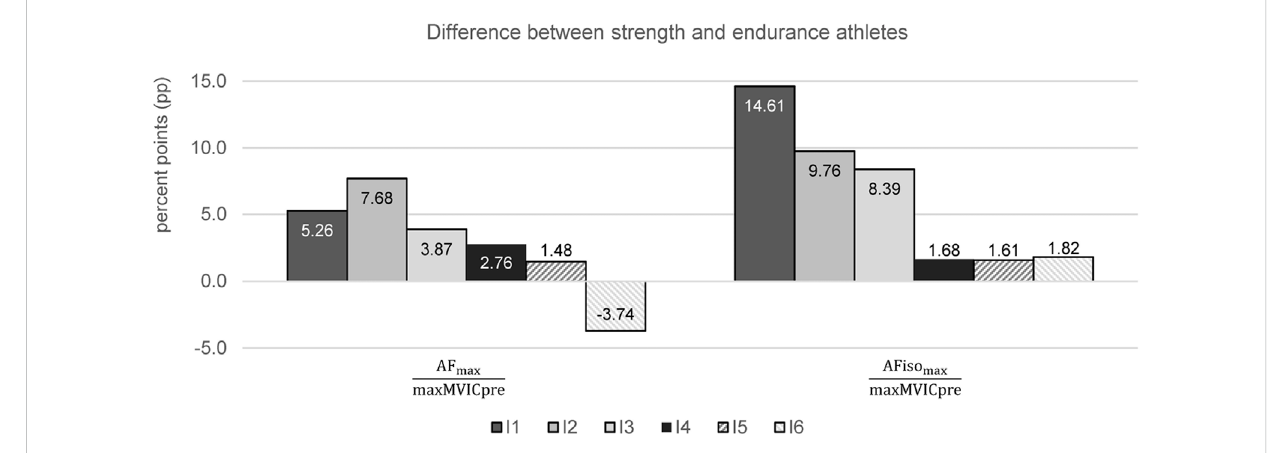
FIGURE 7 Differences between strength and endurance athletes for the ratios of AF max to maxMVICpre and AFiso max to maxMVICpre regarding each interval (I1 – I6) in percent points (pp). Positive values indicate higher ratios for strength athletes. No difference turned out to be signi fi cant.